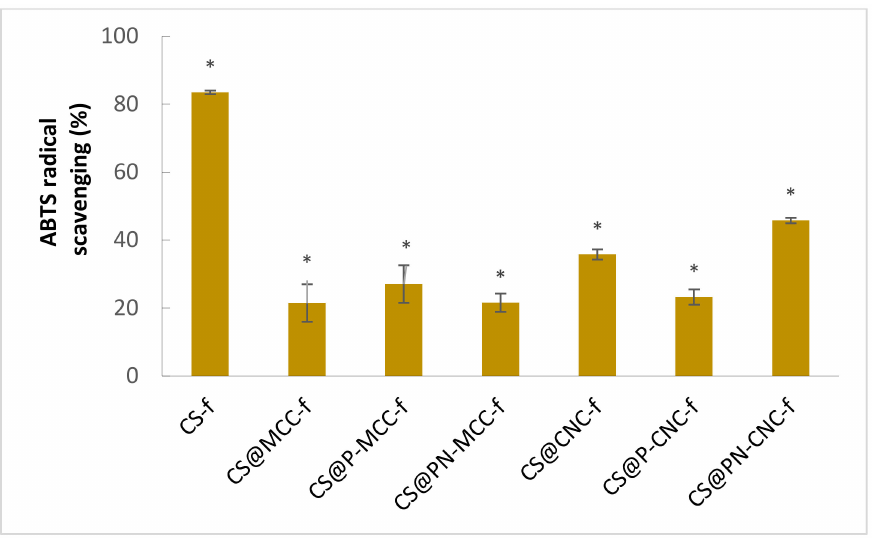
Figure 3. Antioxidant properties of chitosan-cellulose biomaterials after 15 min of incubation, expressed as a percentage of inhibition, n = 6, * p <